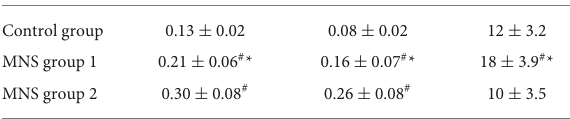
TABLE 4 Levels of the tumor necrosis factor-alpha (TNF- α ), interleukin-6 (IL-6), and acetylcholine (Ach) in the left ventricular tissues in control group, median nerve stimulation (MNS) group 1, and MNS group